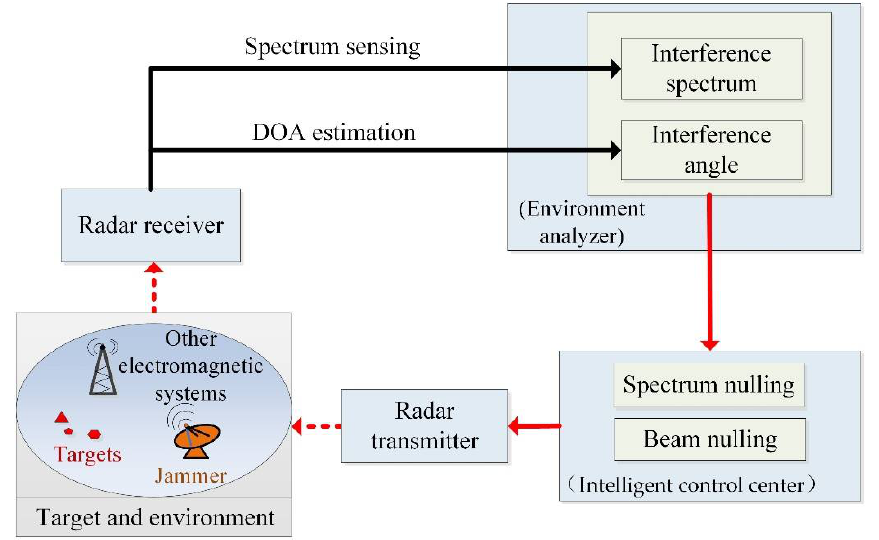
Figure 1. Anti-interference framework of cognitive radar. Specifically, consider a uniform linear array with Q elements separated by distance d . The emission steering vector is